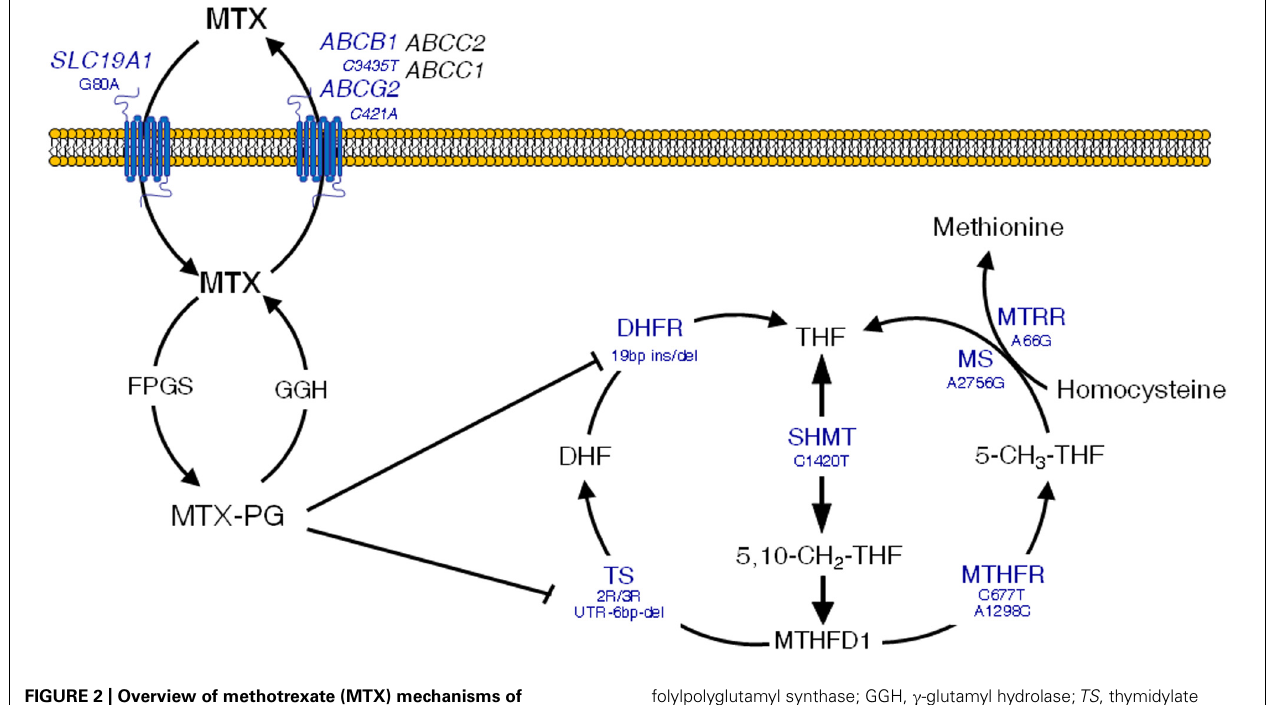
FIGURE 2 | Overview of methotrexate (MTX) mechanisms of action in the folate metabolic pathway. Clinically significant polymorphisms are shown for the main genes involved. MTX-PG, methotrexate polyglutamates; SLC19A1 , solute carrier 19A1; ABCC1 and 2 , ATP-binding cassette C1 and 2 transporters; ABCG2 , ATP-binding cassette G2 transporter, breast cancer resistance protein; ABCB1 , ATP-binding cassette B1 transporter, multidrug resistance; FPGS,